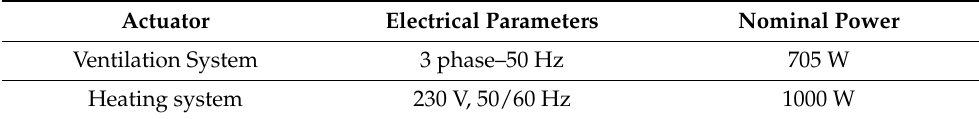
Table 7. Table 7. Actuators. Table 7. Actuators.